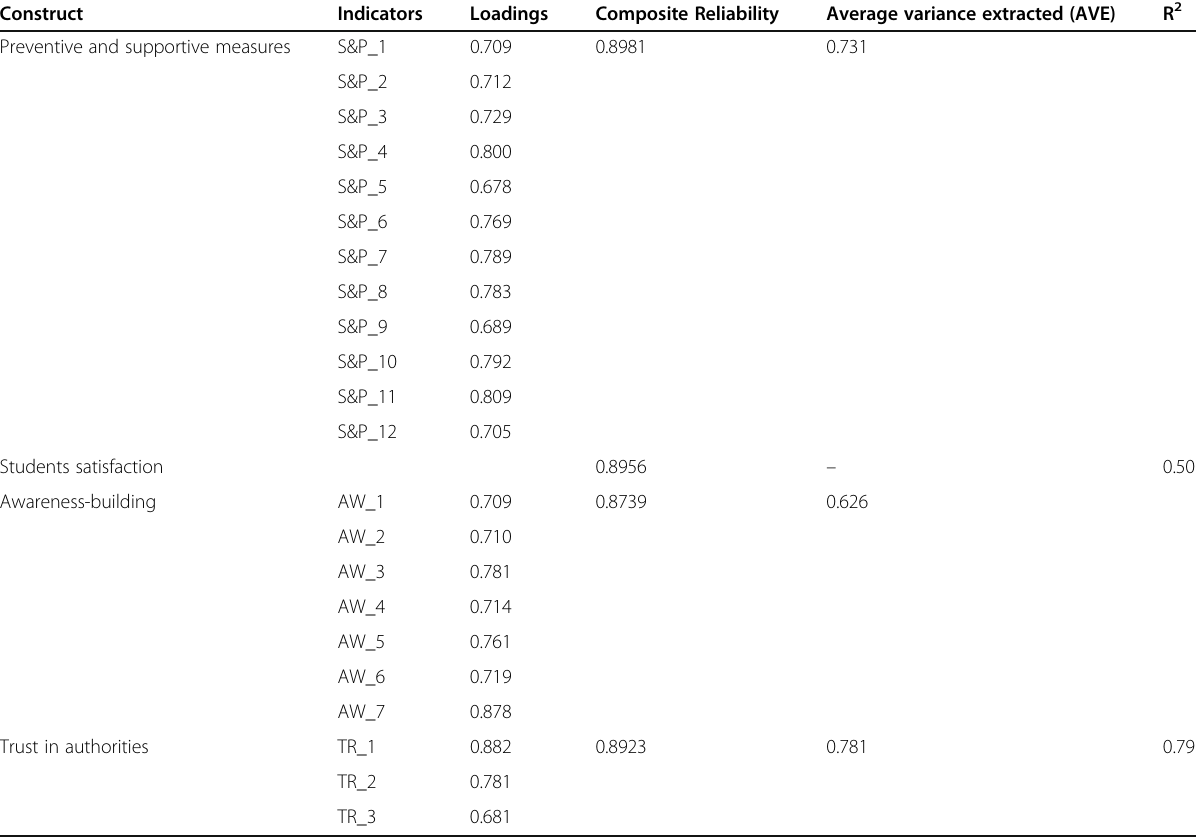
Table 3 PLS-SEM average variance extracted composite reliability and R 2 for endogenous constructs